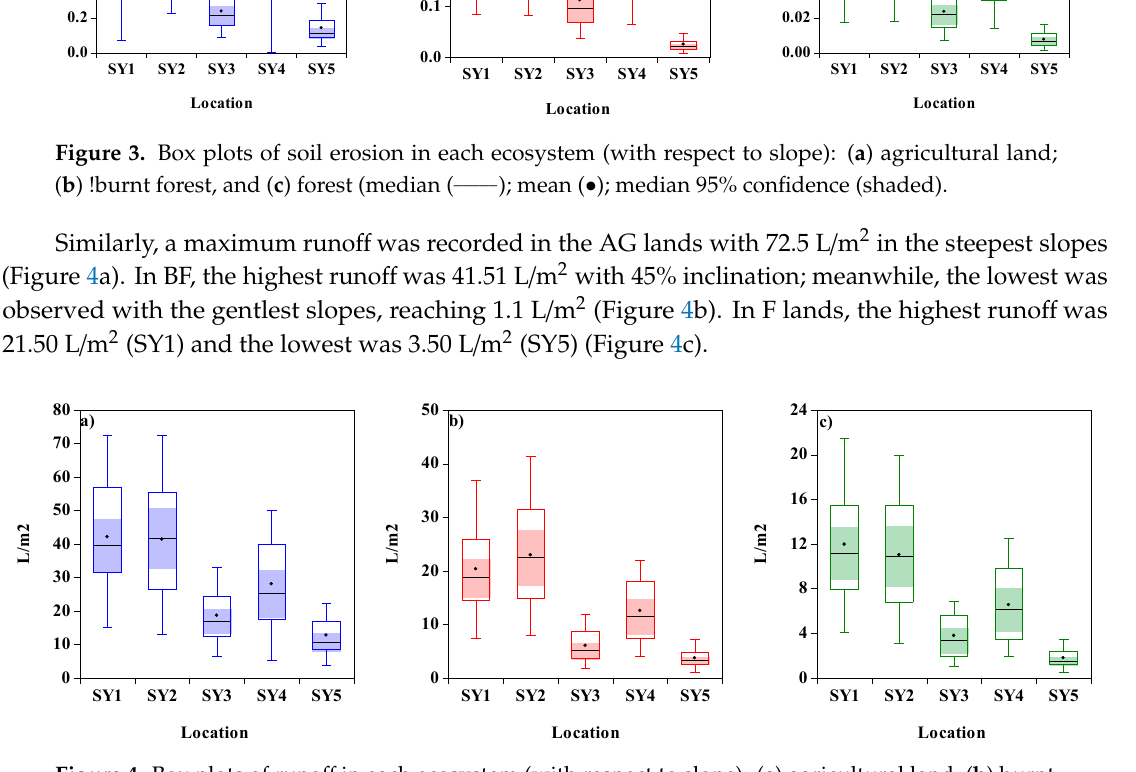
Figure 4. Box plots of runoff in each ecosystem (with respect to slope): ( a ) agricultural land; ( b ) burnt forest, and ( c ) forest (median ( _____ ); mean ( • ); median 95% confidence (shaded).